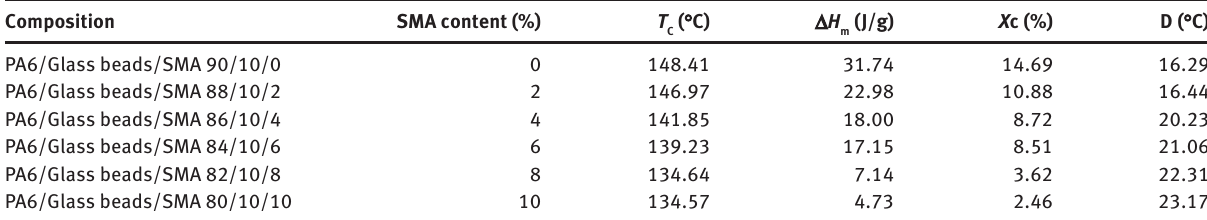
Table 1 DSC data of LPA6/glass beads/SMA